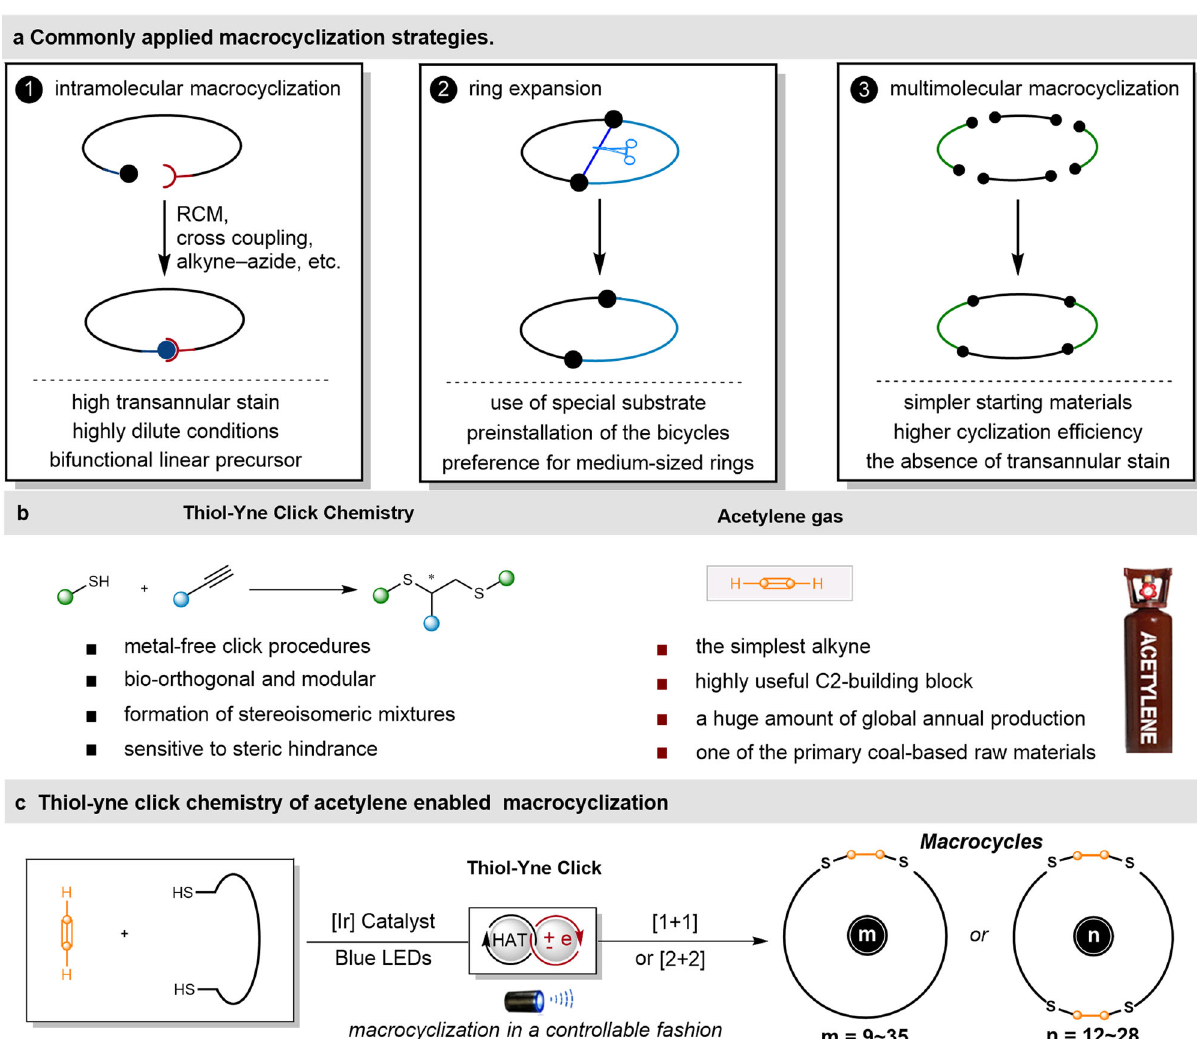
Fig. 1 | Thiol-yne click chemistry of acetylene that enabled macrocyclization. a A general illustration of the three most commonly applied macrocyclization strategies. b The characteristics of the thiol-yne click chemistry and acetylene